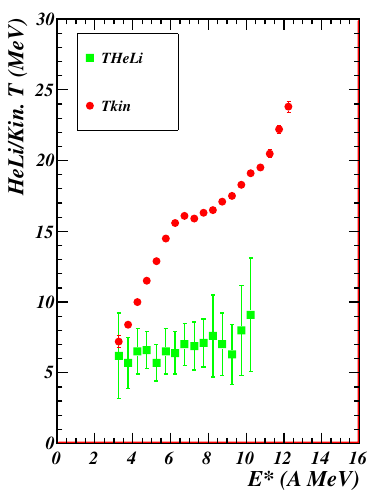
Figure 2: (Colour online) Caloric curves with two different thermome- ters: T kin and T HeLi (see